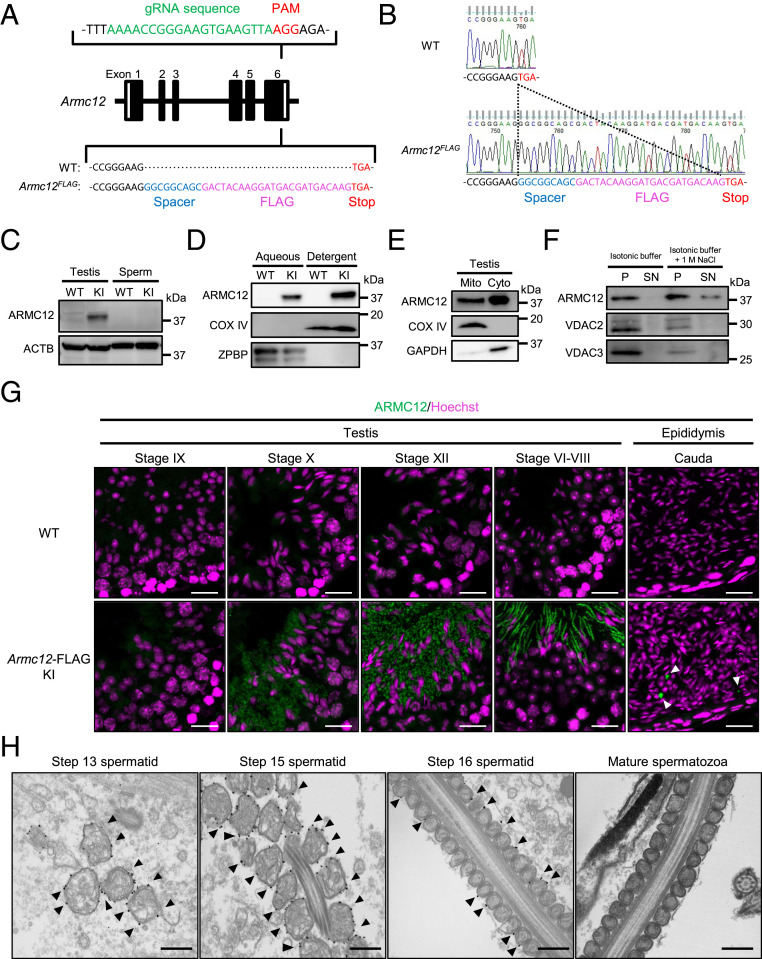
ARMC12 localizes to the mitochondrial outer membrane of spermatids. (A) Schematic diagram of FLAG-tagged alleles of endogenous Armc12. KI allele has a three-amino-acid spacer before the FLAG tag. (B) Control and Armc12FLAG alleles. (C) WB analysis using lysates prepared from the testis and mature spermatozoa from WT and FLAG-tagged Armc12 KI mice. ACTB was used as a loading control. (D) WB analysis using aqueous and detergent fractions of Triton X-114 extracts of the testicular cells. COX IV and ZPBP were used as membrane protein and cytosolic protein markers, respectively. (E) WB analysis using isolated mitochondrial and cytosolic fractions from FLAG-tagged Armc12 KI testicular cells. COX IV and GAPDH were used as mitochondrial protein and cytosolic protein markers, respectively. (F) Mitochondria purified from Armc12-FLAG KI testicular cells were incubated with isotonic buffer or high salt (1 M NaCl) followed by centrifugation to isolate pellet (P) and supernatant (SN) fractions. Equal volumes of protein from each fraction were subjected to WB analysis. VDAC2 and VDAC3 were used as control of integral mitochondrial membrane protein. (G) Immunostaining of FLAG-tagged ARMC12 in Armc12-FLAG KI mouse testis and epididymis. Arrowheads indicate ARMC12 that are not localized in the sperm midpiece. Fluorescent images were false colored using ImageJ software. Spermatogenic stages were identified by the nuclear morphology. (Scale bars, 20 µm.) (H) Detection of immunolabeled FLAG-tagged ARMC12 in testis by TEM using anti-FLAG antibody incubated with 1.4-nm gold-particle–conjugated secondary antibody (arrowheads). (Scale bars, 500 nm.)